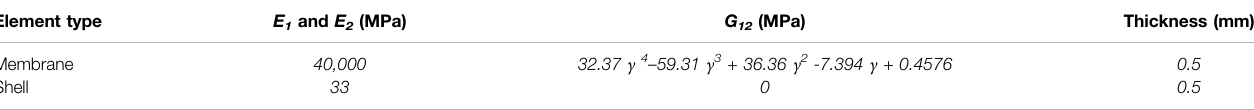
TABLE 2 | Material input parameters for the respective elements in plain woven fabric HypoDrape model (Thompson et al., 2020). ( γ : shear angle in radians). Element